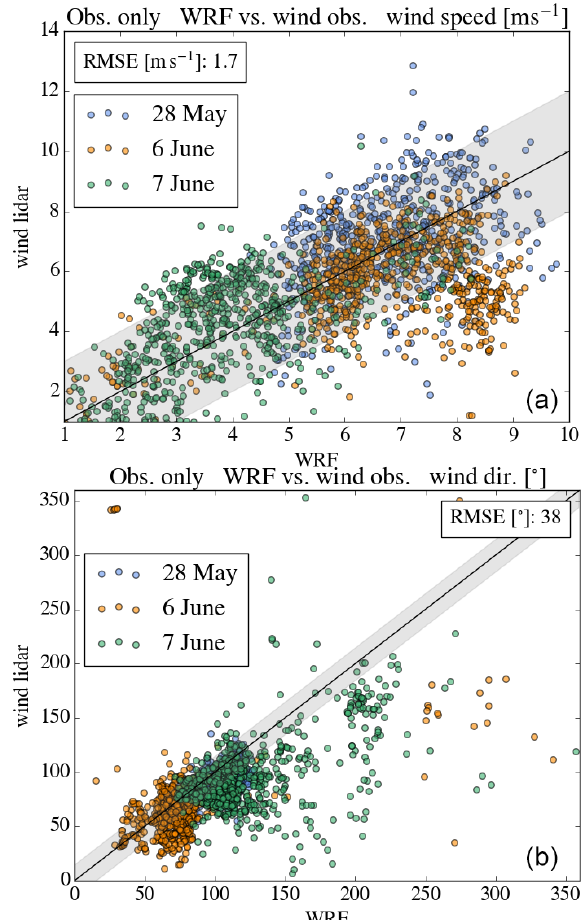
Figure 4. Comparison of WRF wind estimates and wind li- dar observations for the observational period between 07:00 and 17:00UTC for the three days of interest 28 May (blue), 6 June (or- ange), and 7 June (green). Shaded areas include roughly 80% of the data points for ± 2ms − 1 for wind speed in (a) and include roughly 50% of wind direction measurements in a ± 15 ◦ range in (b) . Wind direction simulations differ most from the observations for 7 June (green), a day with generally lower wind speeds than the other two discussed cases. This indicates wind information uncertainties when it comes to low wind speeds. For the wind direction comparison, note that values close to 0 and 360 ◦ represent virtually the same wind direction but may introduce an error to the root mean square error (RMSE)